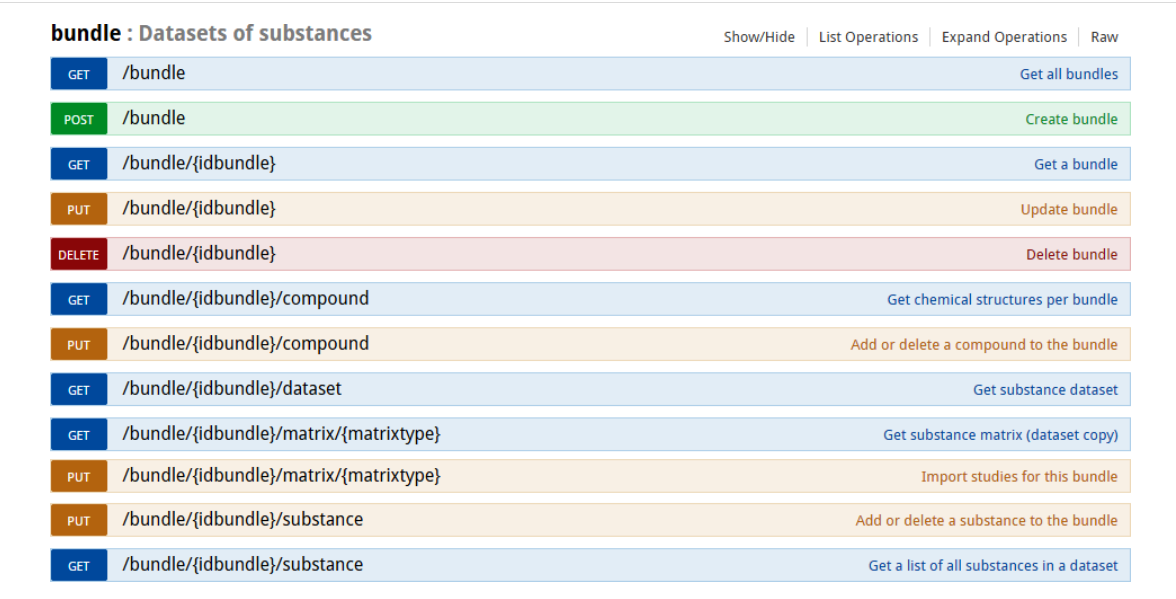
Figure 9: Bundle API documentation at http://enanomapper.github.io/API. A bundle is a REST resource, allowing one to retrieve all information about a selected set of NMs and endpoints by a singe REST call. The PUT calls allow one to select or deselect the NMs and the